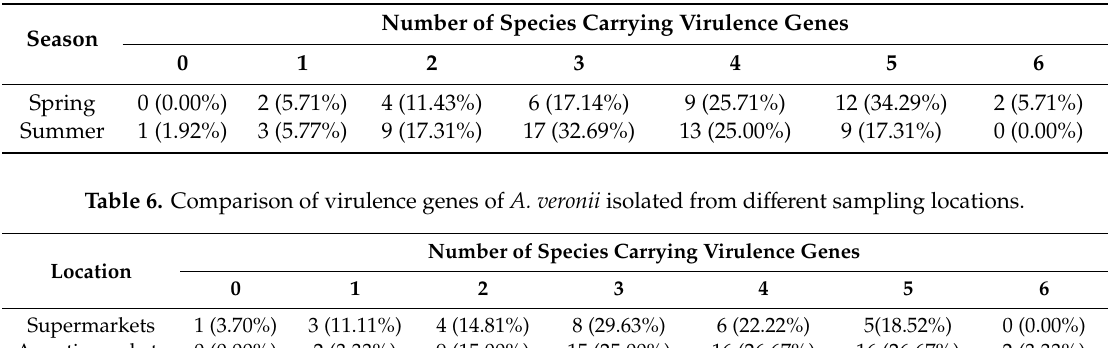
Table 5. Comparison of virulence genes of A. veronii isolates in di ff erent seasons.